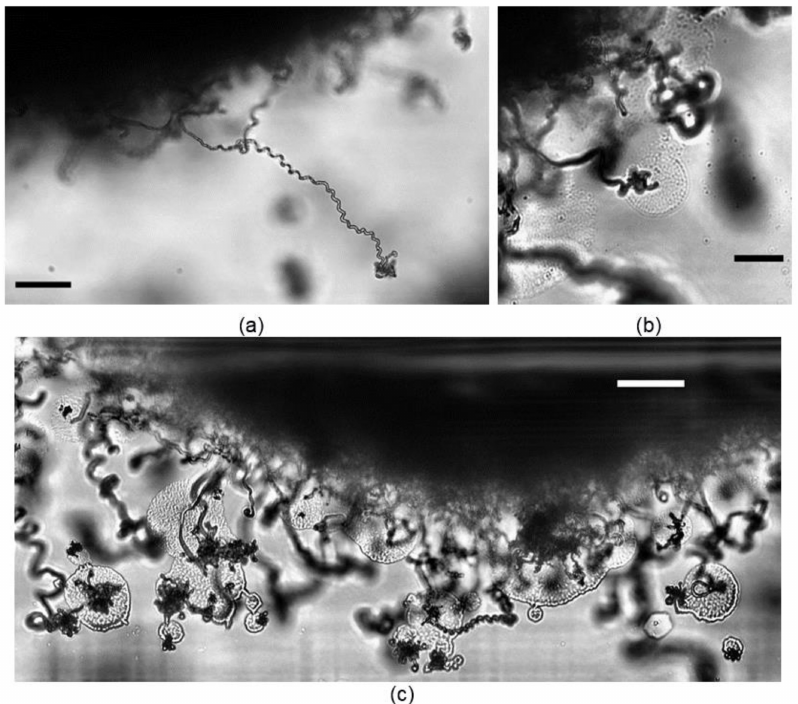
Figure 4. Methane hydrate filaments in run 5, growing into the gas from sand grains at 7 MPa and − 16 ◦ C. ( a ) A self-supporting filament; ( b,c ) Filaments drooping onto the floor of the glass cell, giving rise to localised halos. Scale bars: ( a,c ) 50 µ m; ( b ) 20 µ m.